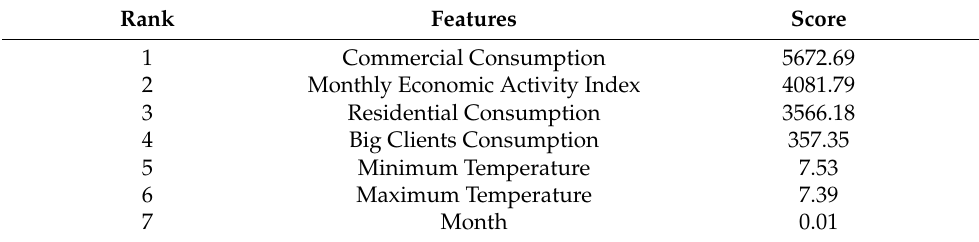
Table 3. Feature Ranking According to the SelectKBest